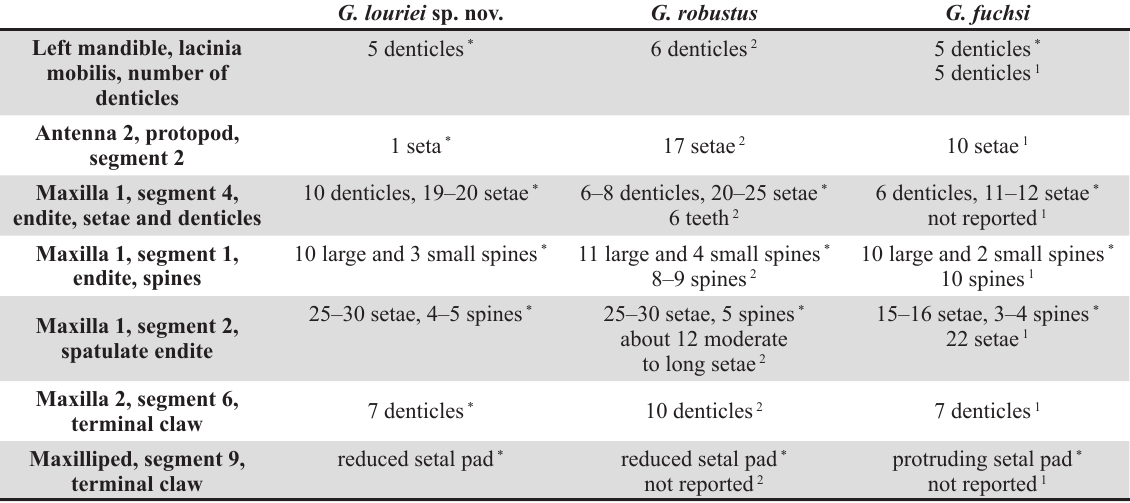
Table 2. Morphological comparison of the species of Godzillius Schram, Yager & Emerson, 1986: G. louriei sp. nov., G. robustus Schram, Yager & Emerson, 2013 and G. fuchsi Gonzalez, Singpiel & Schlagner, 1986. All characters denoted with an asterisk ( * ) are from observations in this study. All other characters are from their respective species descriptions ( 1 = Gonzalez et al . 2013; 2 = Schram et al.